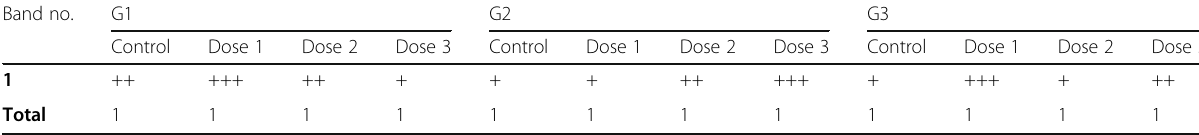
Table 10 Effects of different ethyl methane sulfonate (EMS) doses on polyphenol oxidase (PPO) isozymes of lentil cultivars Band no.